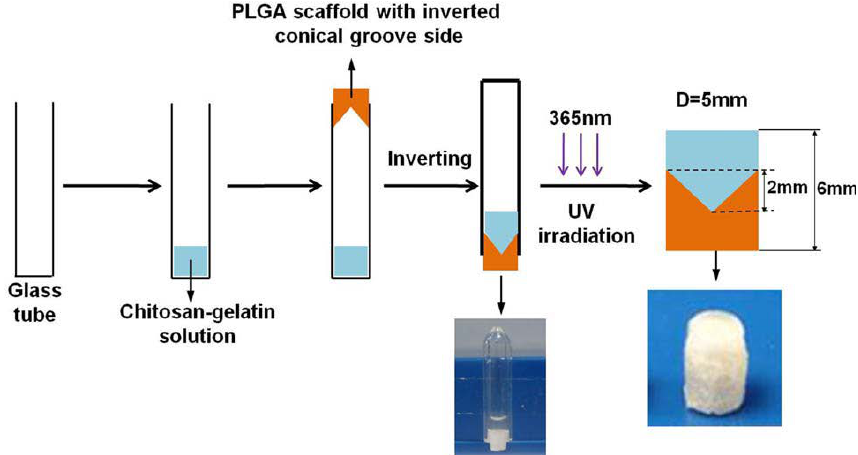
Figure 3. Scheme of the preparation of the conically graded chitosan-gelatin hydrogel/poly(lactide- co -glycolide) (PLGA) scaffold. Adapted with permission from ref [38]. Copyright 2014 by John Wiley & Sons,